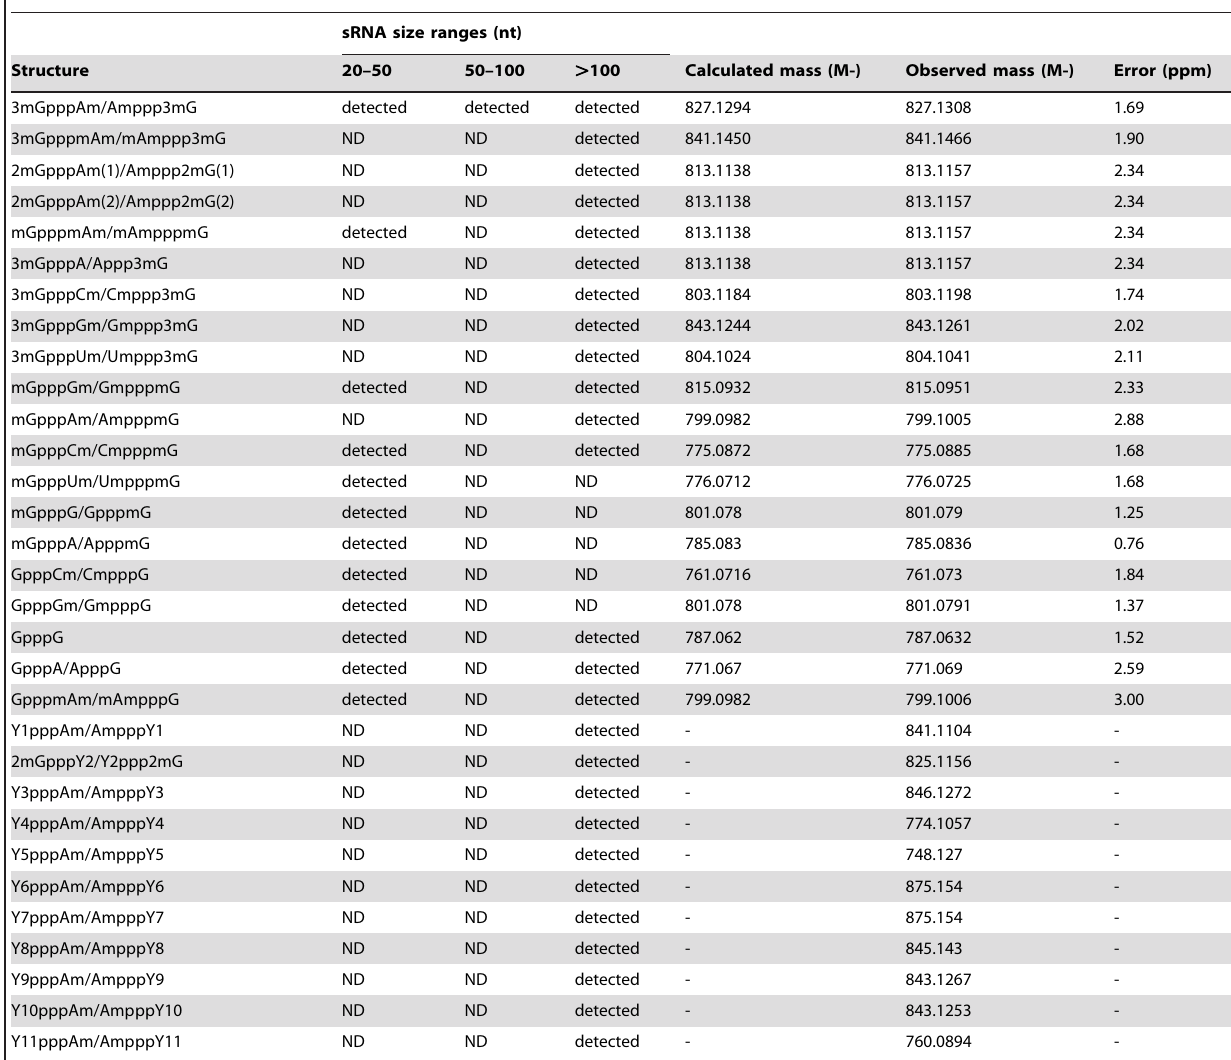
Table 1. Summary of cap structures detected in liquid chromatography-fractionated